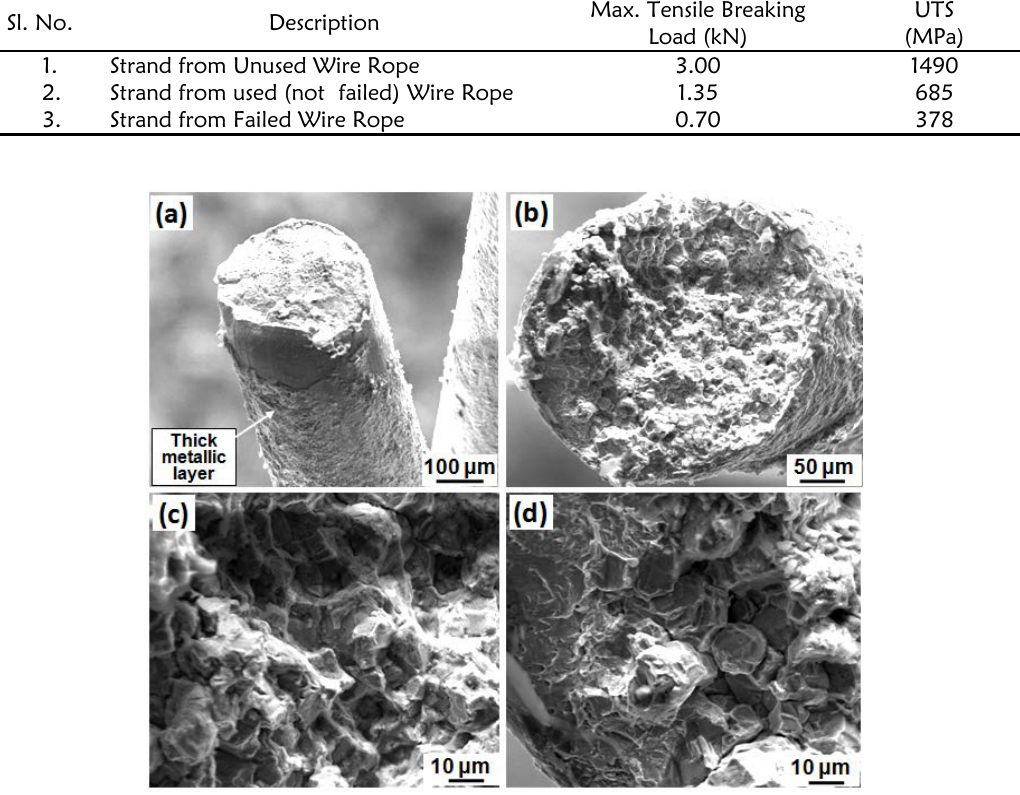
Figure 8: SEM fractographs of tensile tested failed wire rope: (a) low magnification and (b-d) High magnification reveals flat fracture with intergranular mode of failure.